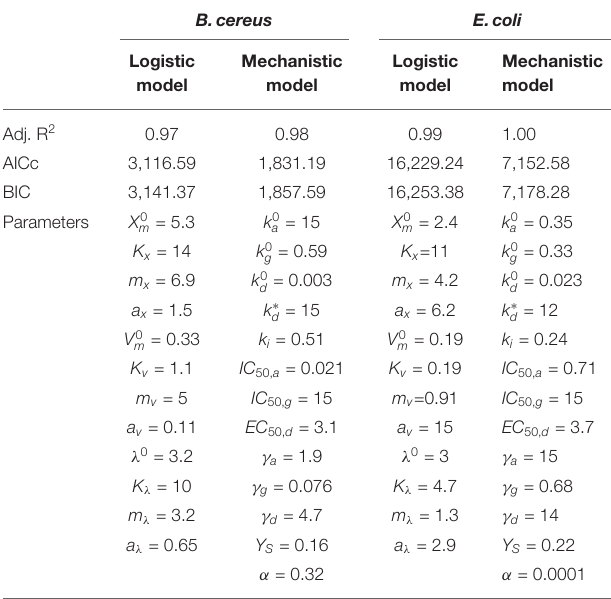
TABLE 3 | Performance of both models to reproduce the data (measured in terms of the Adjusted R 2 , AICc, BIC) and estimated